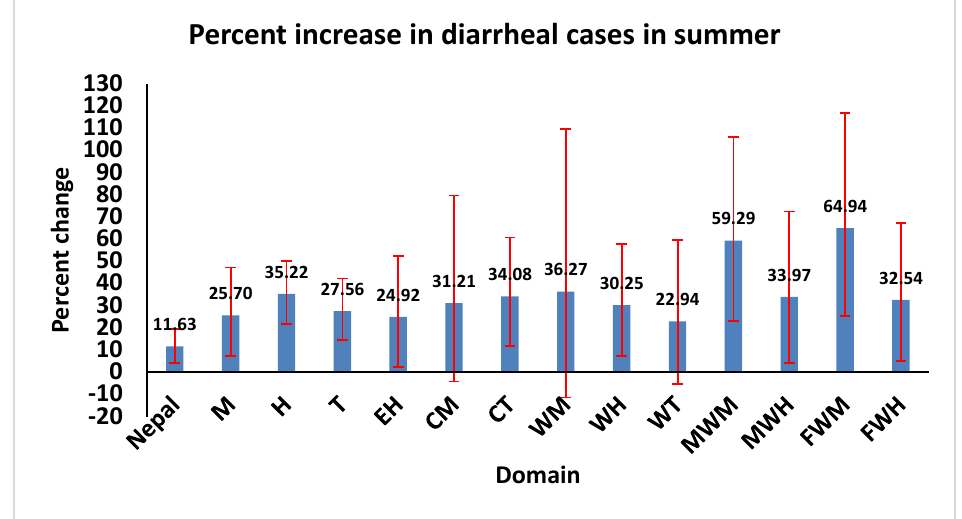
Figure 6. Percentage increase in diarrheal cases in summer season with reference to winter season in 13 eco-development regions, from July 2002 to June 2014. The projections were based on coefficients from negative binomial time-series GLMs.